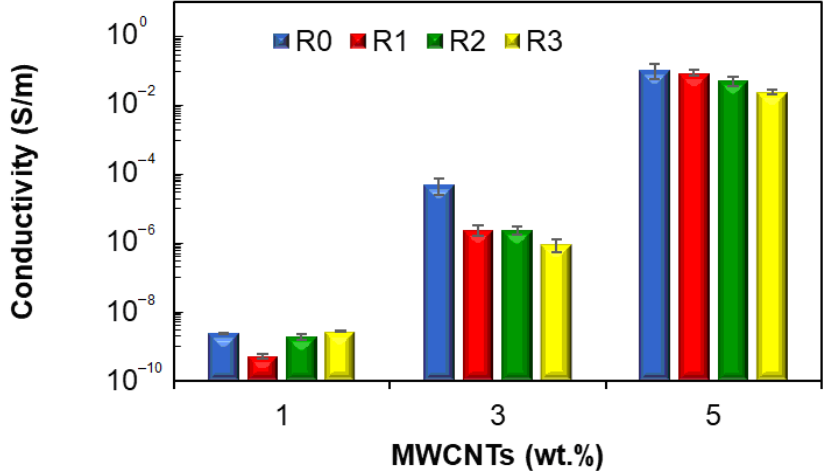
Figure 15. Electrical conductivity of EVA nanocomposites as a function of MWCNTs and recy- cling.